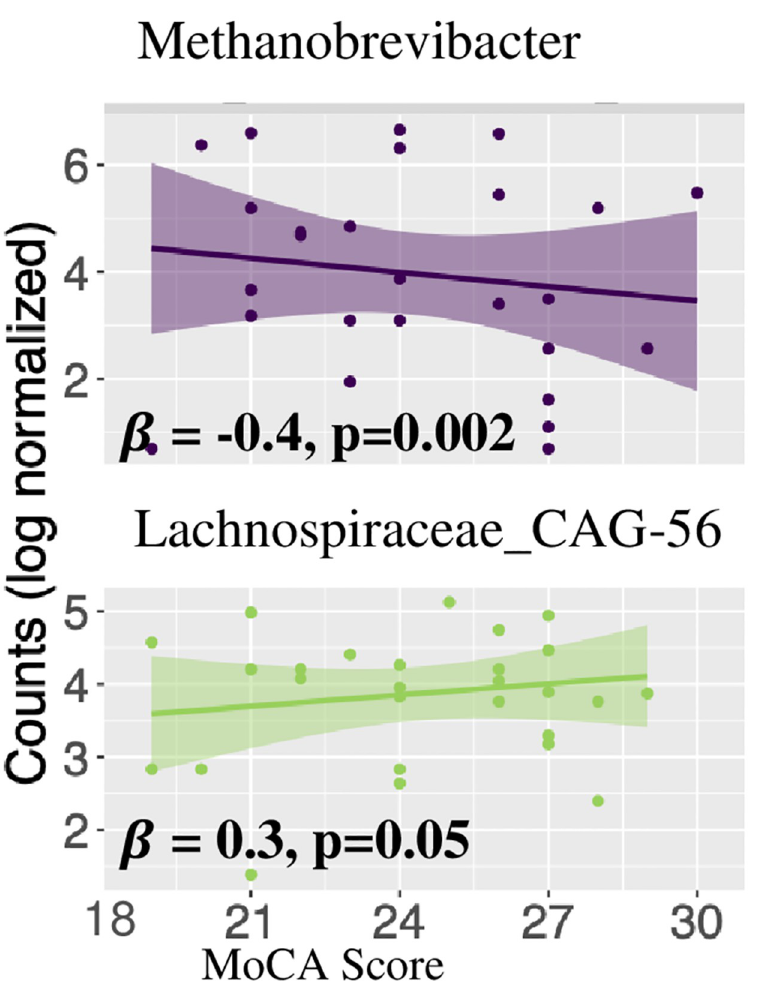
Fig 4. Log normalized counts of genera significantly associated with MoCA score. Scatter plots of log normalized counts of two genera significantly associated with MoCA score in adjusted models. β s correspond to beta coefficients from the zero-inflated adjusted linear model. Scatter plots are overlayed with a linear regression line to assist in pattern visualization. Abbreviations: MoCA—Montreal Cognitive Assessment.